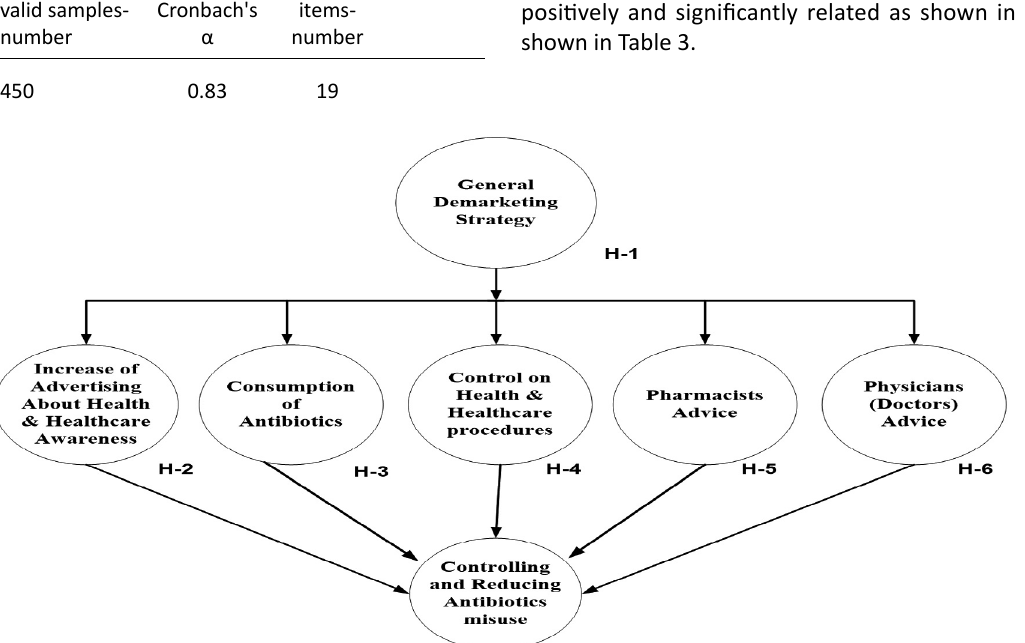
Table 1. Validity and Measurement of the Tool (Tools validation and measurements) valid samples-